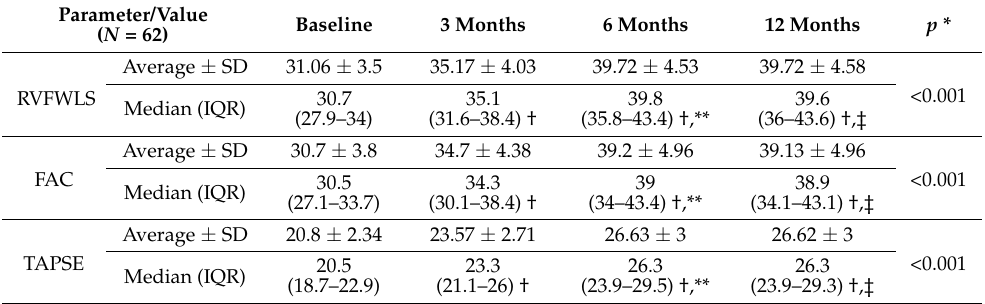
Table 2. Dynamic evolution of RVFWLS, FAC, and TAPSE values from baseline to 3/6/12 months.